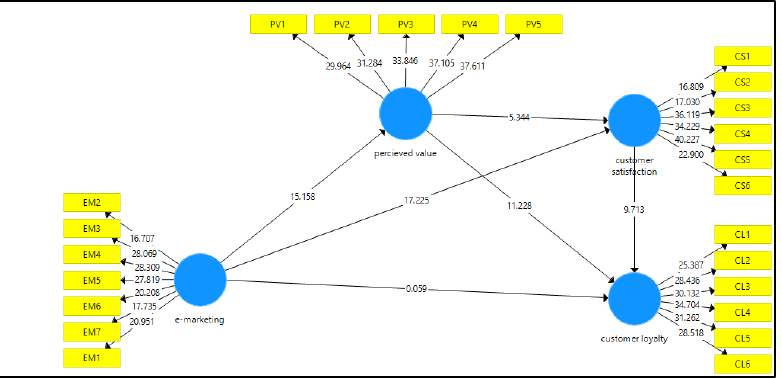
Fig. 1. Structural Research